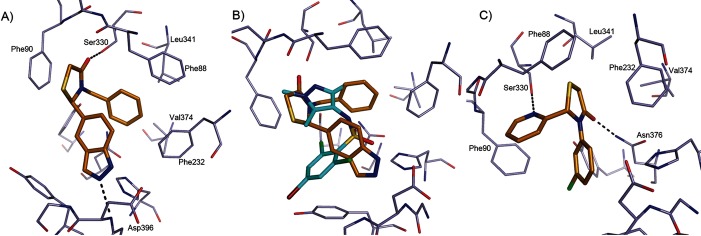
Binding mode of thiazolidinone-based ligands to LmNMT. A) Compound 6 (C atoms gold) binding to LmNMT (C atoms grey), adopting binding mode T1. Hydrogen bonds are shown as dashed lines, and key residues are labelled. B) Overlay of the binding mode of 6 with a pyrazole sulfonamide ligand (C atoms cyan, PDB code: 4A30).[9] C) Compound 7 (C atoms gold) binding to LmNMT (C atoms grey), adopting binding mode T2. The image was prepared with PyMOL.